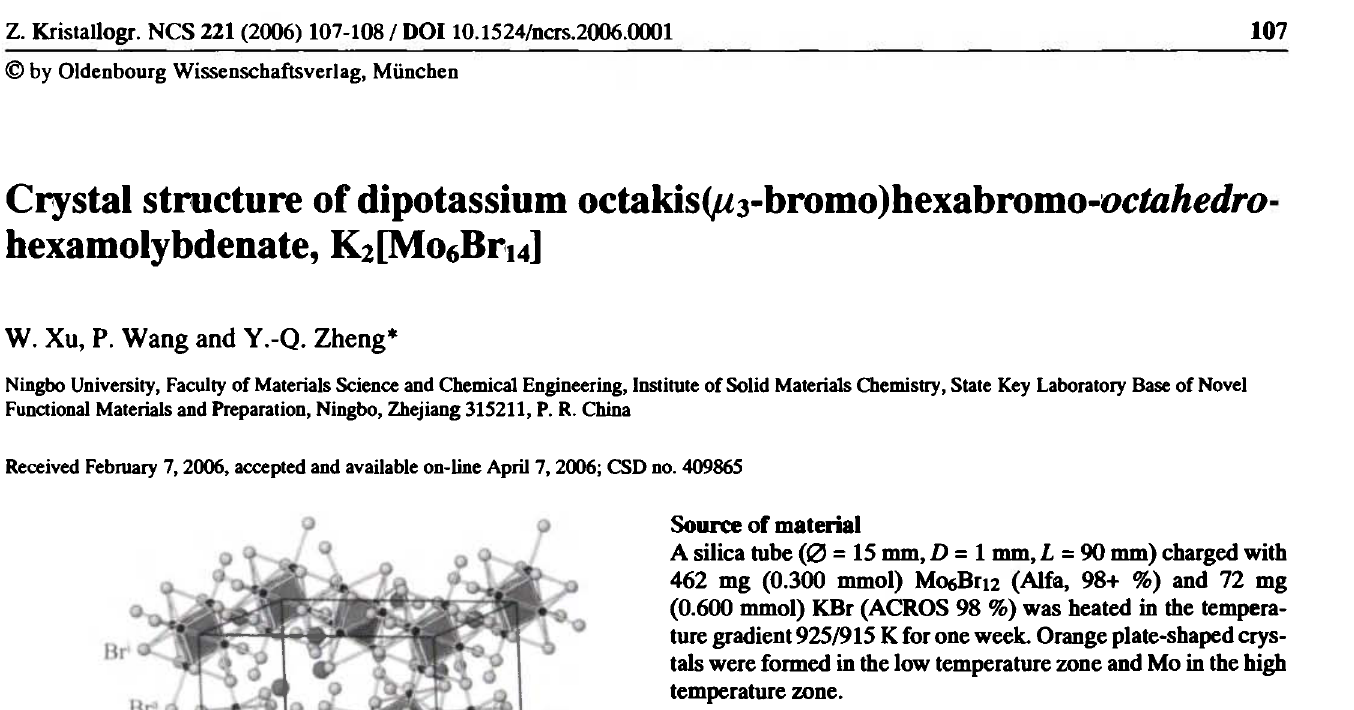
Table 1. Data collection and handling.